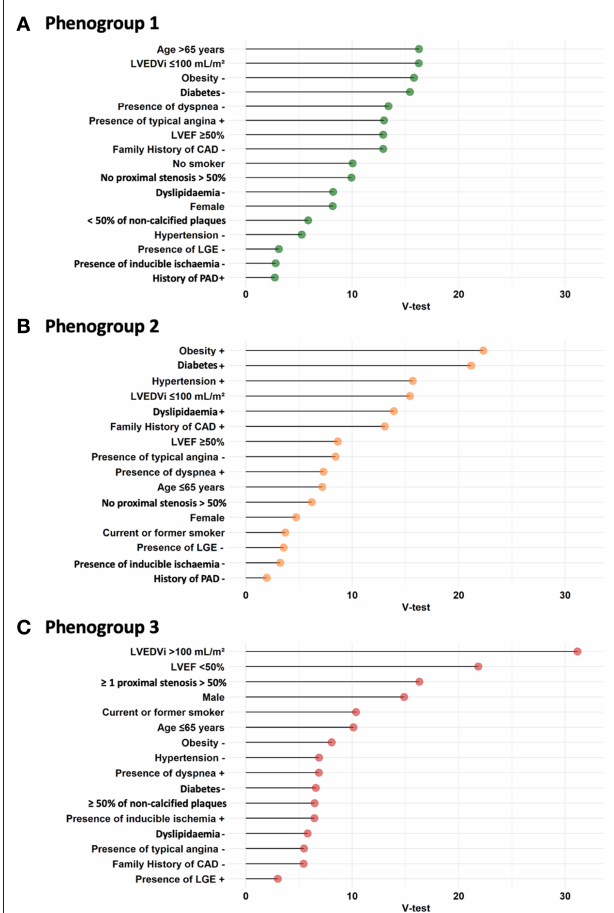
score indicates over-representation of this variable in the applicable phenogroup. Same abbreviations as Table 1